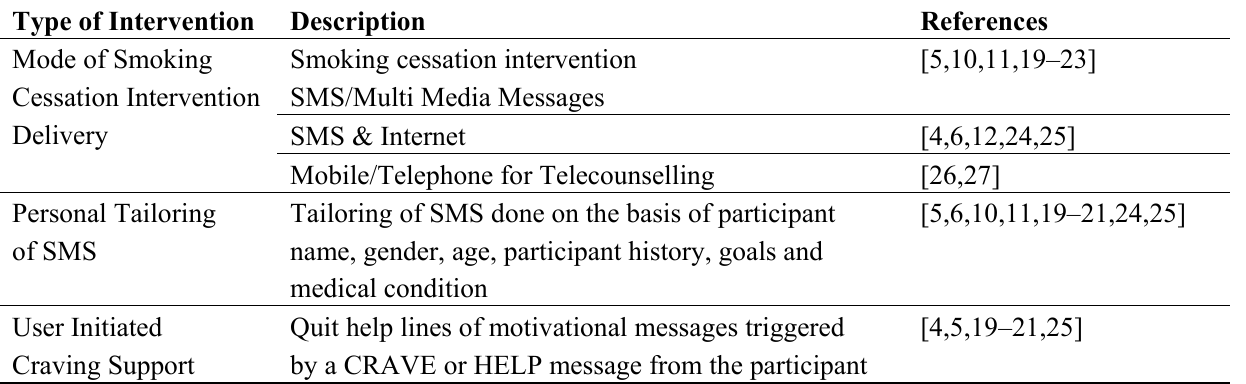
Table 2. Review of Mobile Based Smoking Cessation